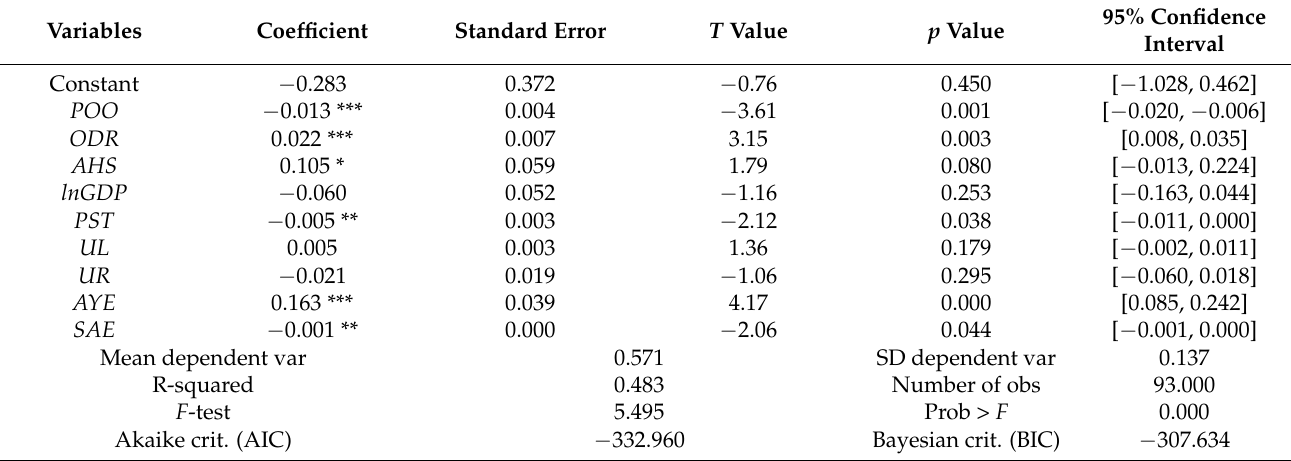
Table 4. Results of model estimation.